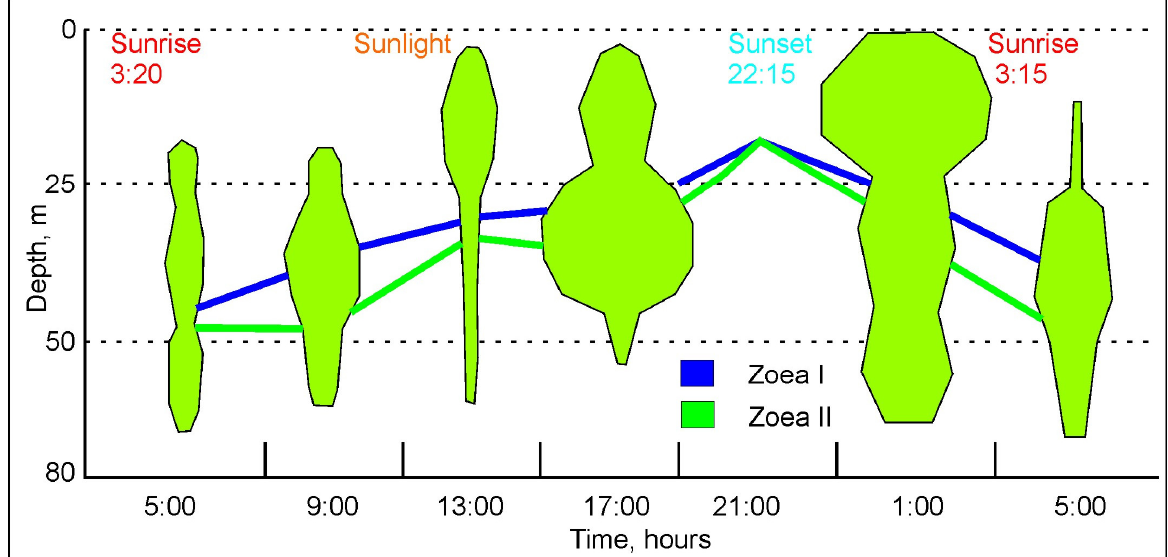
Figure 10. Vertical distribution of red king crab larvae in Russian waters of the Barents Sea (Medvezhya Bay, 3–4 May 1999) (modified from [68]). The areas of the polygons are proportional to the number of RKC larvae at different depths.